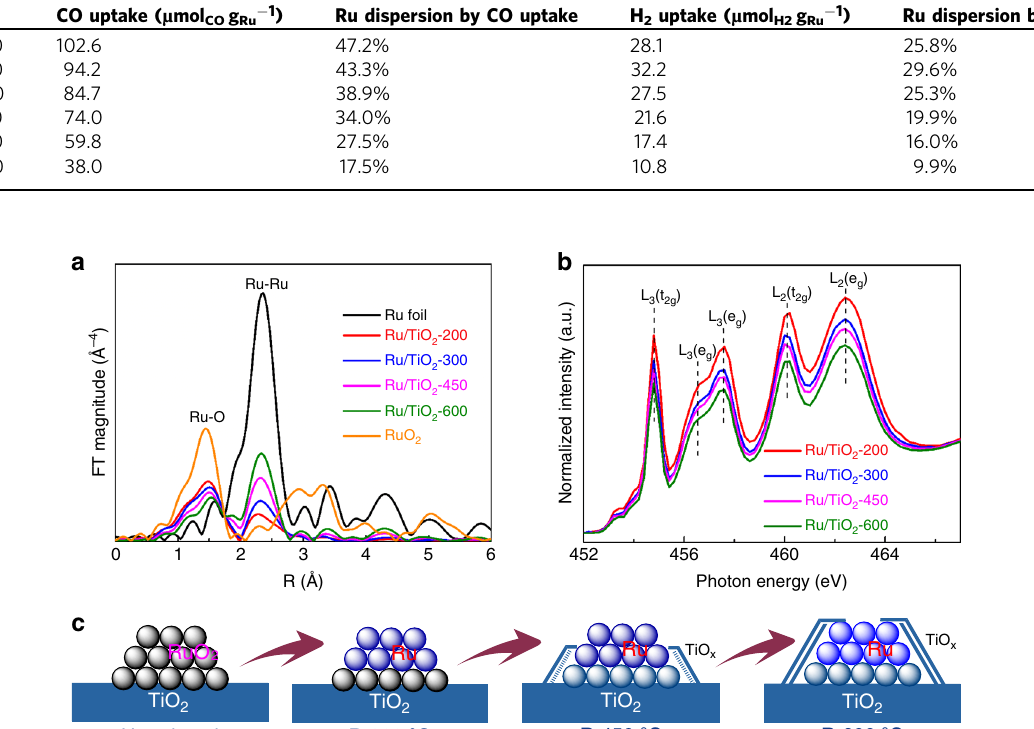
Fig. 2 The evolution of Ru/TiO 2 catalysts reduced at different temperatures. a Fourier transforms of the k 3 -weighted EXAFS of Ru K -edge for Ru foil, RuO 2 , and the Ru/TiO 2 catalysts pretreated at different temperatures (Ru/TiO 2 - x samples). b Ti L 3,2 -edge XANES for the Ru/TiO 2 catalysts pretreated at different temperatures (Ru/TiO 2 - x samples). c A schematic illustration of the structural evolution of Ru/TiO 2 at different stages of